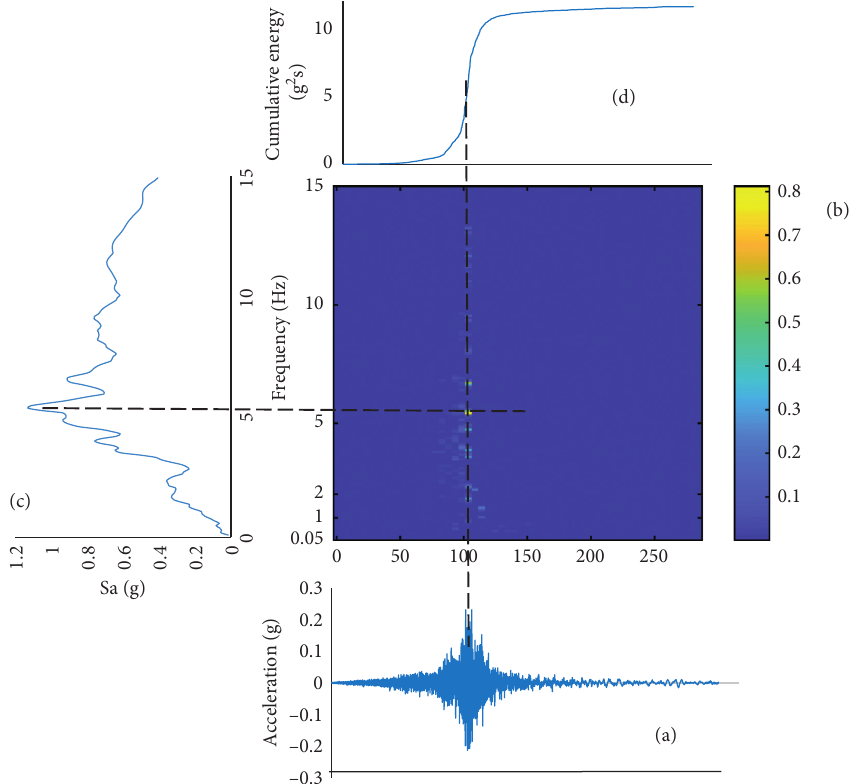
Figure 9: Relationships pertaining to time and frequency domains are illustrated through wavelet packets decomposition for the record CHB002EW: (a) acceleration time history; (b) distribution of squared wavelet coefficients; (c) acceleration response spectrum; (d) cu- mulative energy